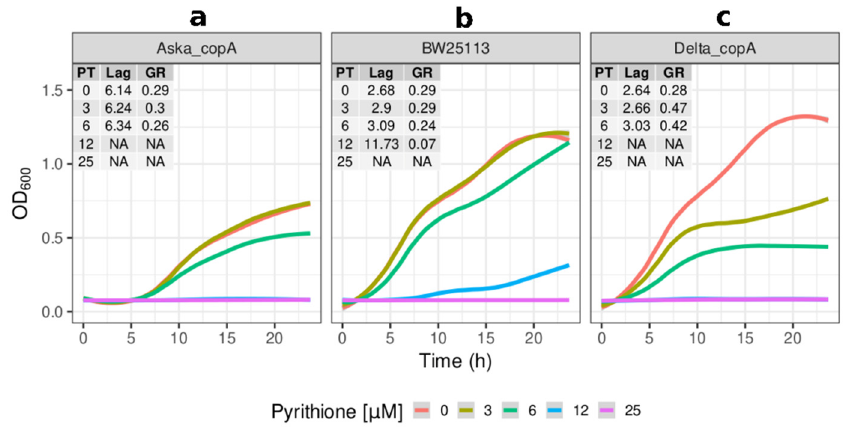
Figure 2. Effects of copA on the sensitivity of E. coli to pyrithione. Growth (OD 600 ) at incremental concentrations of pyrithione in complex media (LB) of the ( a ) Aska clone carrying episomal copies of copA (Aska_copA), ( b ) the reference strain BW25113, and ( c ) the copA knockout strain (Delta_copA). Insets: PT: concentration of pyrithione in micromolar (µM), Lag: length of lag phase in hours, GR: growth rate fitted from optical densities of the cultures in exponential phases. The colour coded lines represent the fitted data with the parametric non-linear method of least squares. NA (non-applicable): data below detection limit.